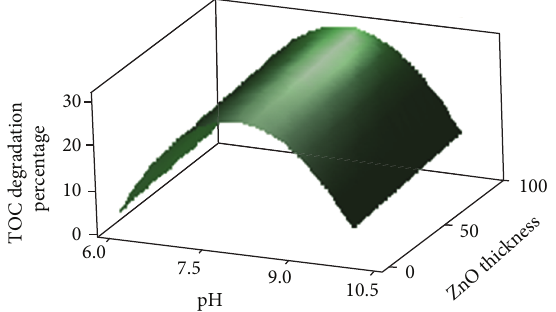
Figure 3: Surface Response graph in terms of TOC percentage removal by ZnO coating thickness and pH.